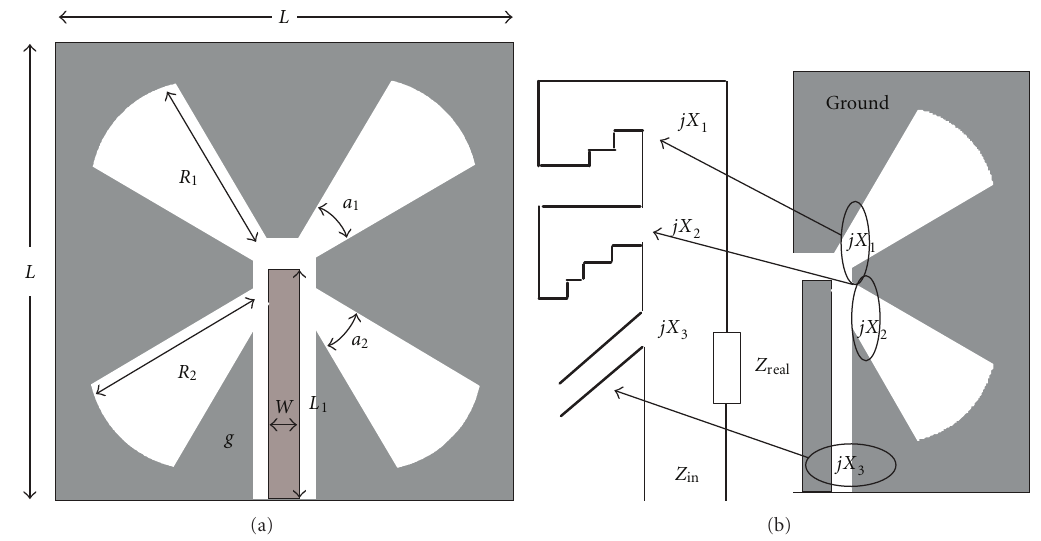
Figure 5: (a) The geometry of antenna 3 and (b) The equivalent transmission line circuits for antenna 3.